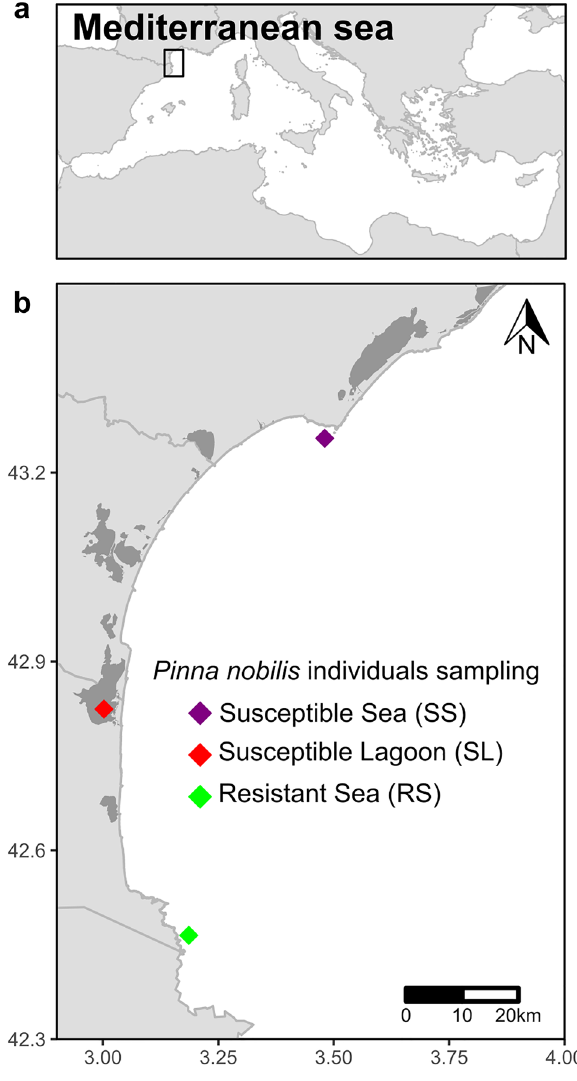
Figure 1. Sampling location of P. nobilis individuals resistant or susceptible to H. pinnae parasite. ( a ) P. nobilis species is endemic to the Mediterranean Sea. ( b ) Individuals were sampled in three different locations in the Mediterranean Sea: Resistant from the sea were sampled in Peyrefite Bay (green), Susceptible from the Sea were sampled in Agde (Purple) whereas Susceptible from the Lagoon were sampled in Leucate (Red). RS, Resistant from Sea; SS, Susceptible from Sea; SL, Susceptible from